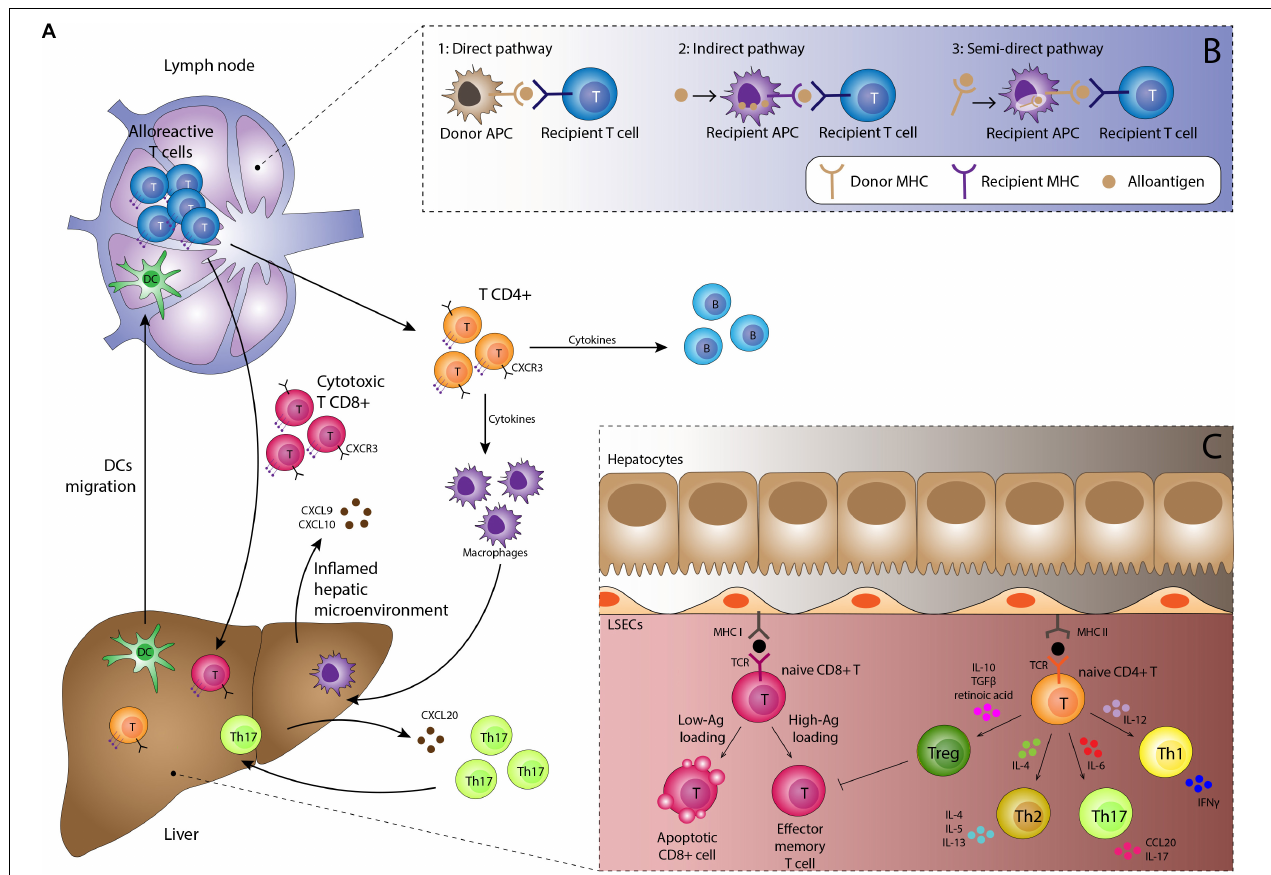
FIGURE 2 | (A) Immunological basis of TCMR. Activated dendritic cells migrate to lymphoid tissue presenting alloantigen on MHC class I and II molecules. Interaction with naïve alloreactive T-cells in the presence of appropriate co-stimulatory molecules and a pro-inflammatory cytokine milieu results in proliferation of alloreactive CD4 + and CD8 + effector T-cells and subsequent B-cell proliferation. Migration to the liver is orchestrated by chemokines such as CXCL9 and CXCL10 interacting with the CXCR3 receptor on lymphocytes in addition to complex interactions with the unique immunomodulatory liver sinusoidal endothelial cells. Lymphocyte subsets such as Th17 cells have specific recruitment mechanisms, providing potential therapeutic targets. Cells of the innate immune system including macrophages, neutrophils and eosinophils are recruited to the liver and along with the effector T-cells mediate tissue damage, resulting in the clinical